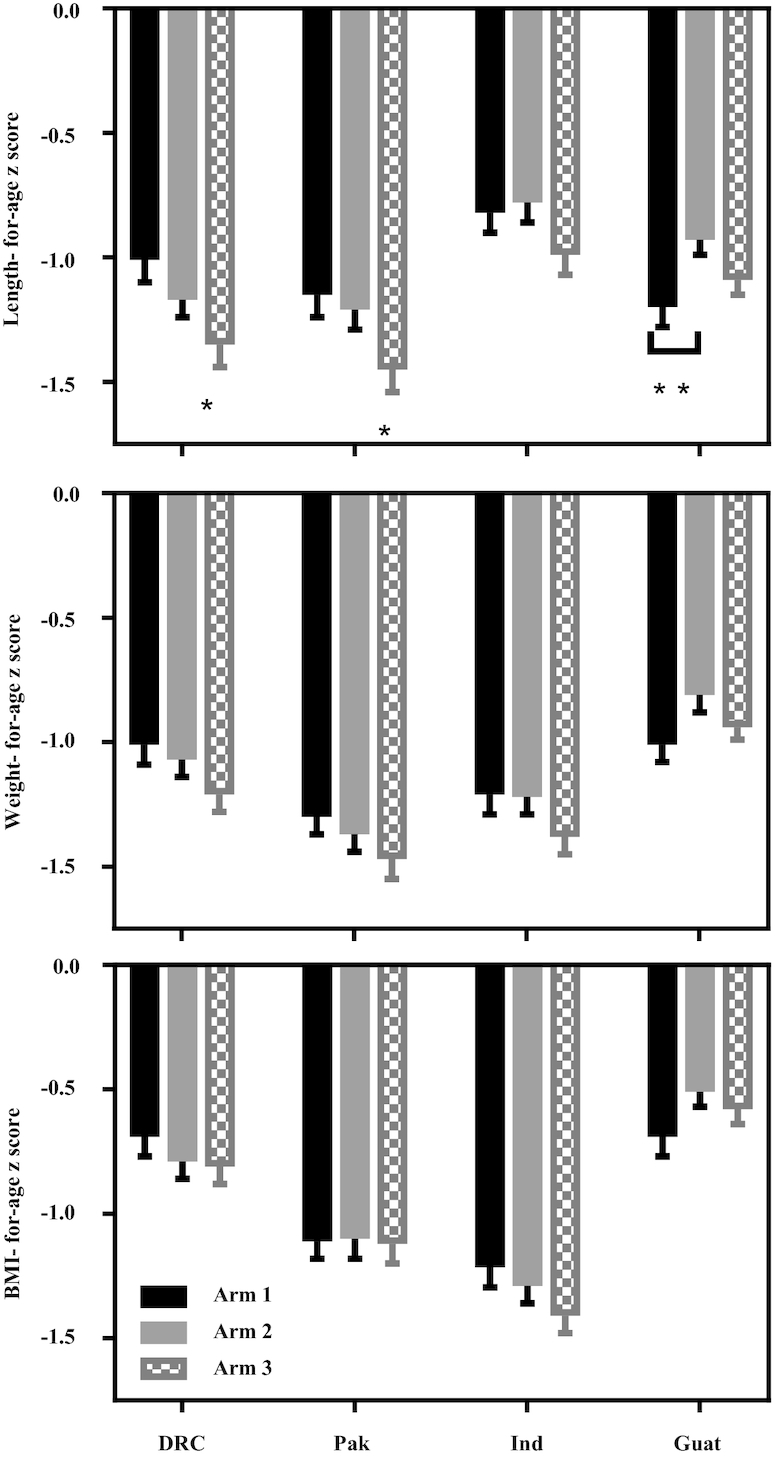
Mean ± SEM length-, weight-, and BMI-for-age z scores for each site by treatment arm for non-gestational-age-adjusted data. P values comparing mean z scores for pairwise comparisons of the treatment effect were obtained from linear models for the outcome of interest, adjusted for cluster. Pairwise comparisons of treatment arms within an individual site are evaluated at a significance level of α = 0.00625. *Mean length-for-age z score for Arm 1 differs from Arm 3 in Pak (P = 0.0057) and in DRC (P = 0.0042). **Arm 1 differs from Arm 2 in Guat (P = 0.0044). Sample size for each arm within a site ranged as follows: n = 183–199 (DRC), n = 201–236 (Pak), n = 199–200 (Ind), and n = 189–216 (Guat). DRC, Democratic Republic of the Congo; Guat, Guatemala; Ind, India; Pak, Pakistan.